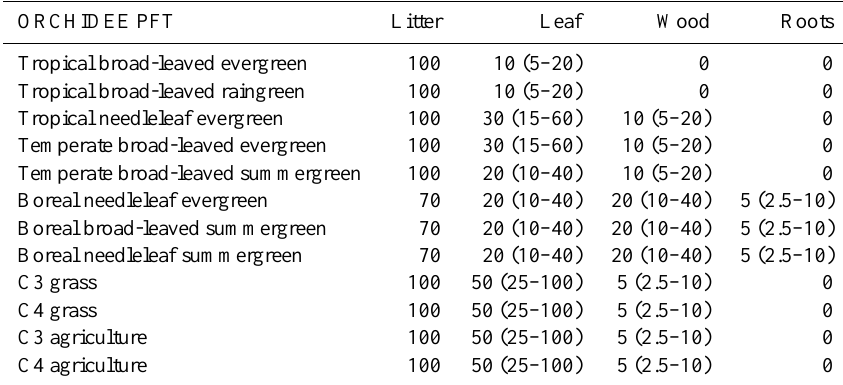
Table 3. Fraction of vegetation available for burning in the considered carbon pools (following Hoelzemann et al., 2004). The minimum and maximum values are given in parentheses. ORCHIDEE PFT Litter Leaf Wood Roots